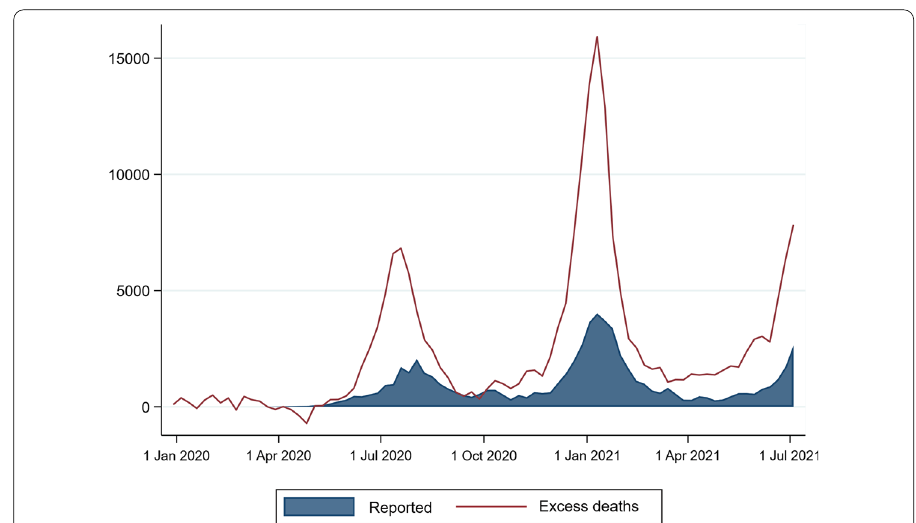
Fig. 3 Comparison of the numbers of excess deaths to the officially reported number of COVID-19